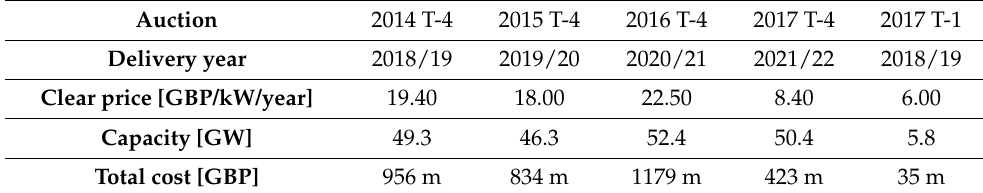
Table 1. Clearing price, capacity awarded and total forecasted cost for CM auction [56–60].